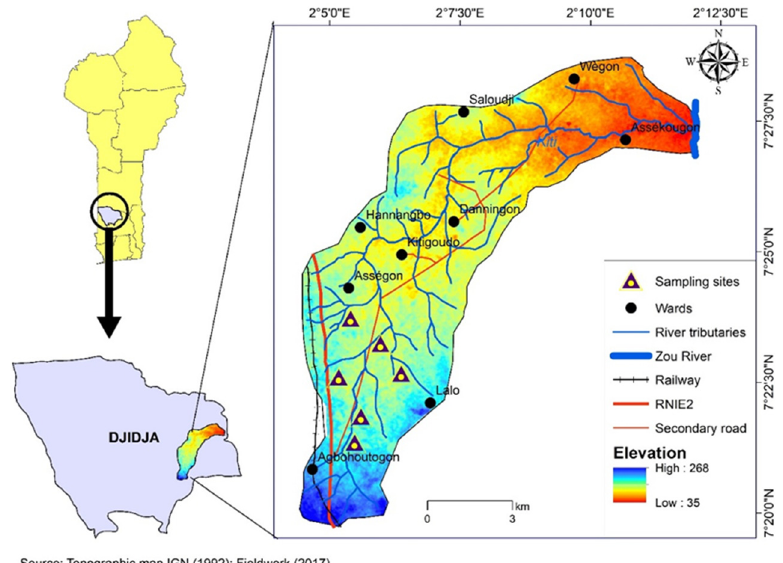
Figure 1. Map showing the sampling sites.